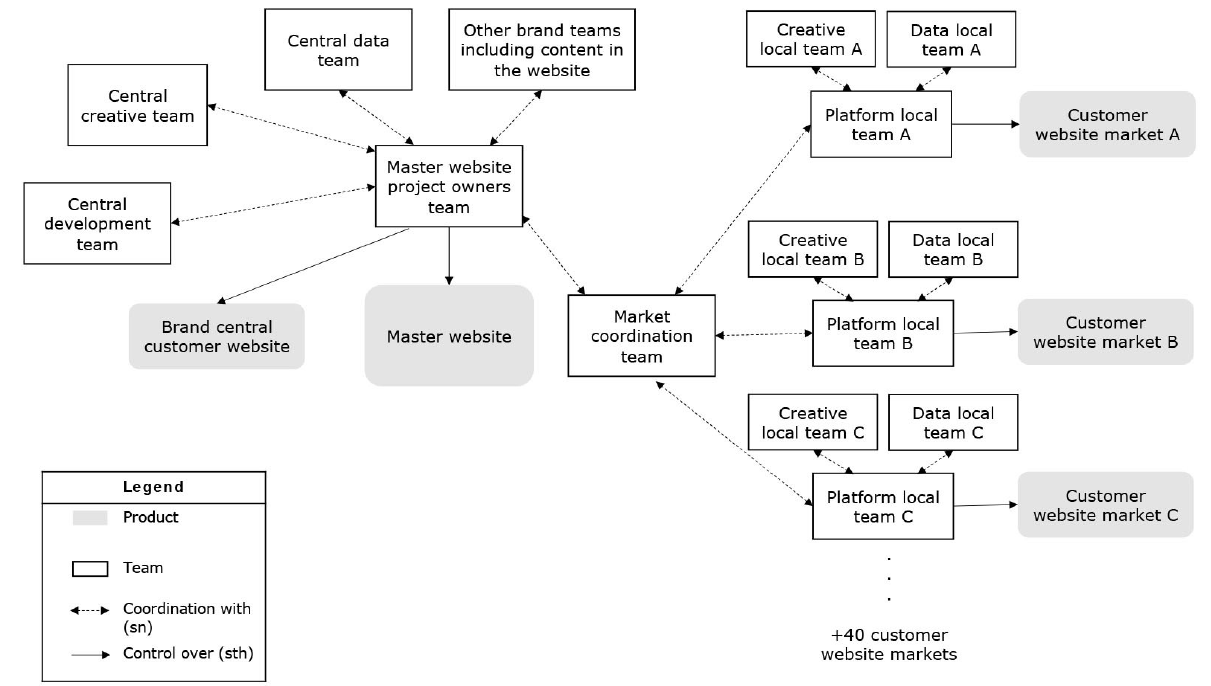
Figure 2. Approximate diagram of the organization